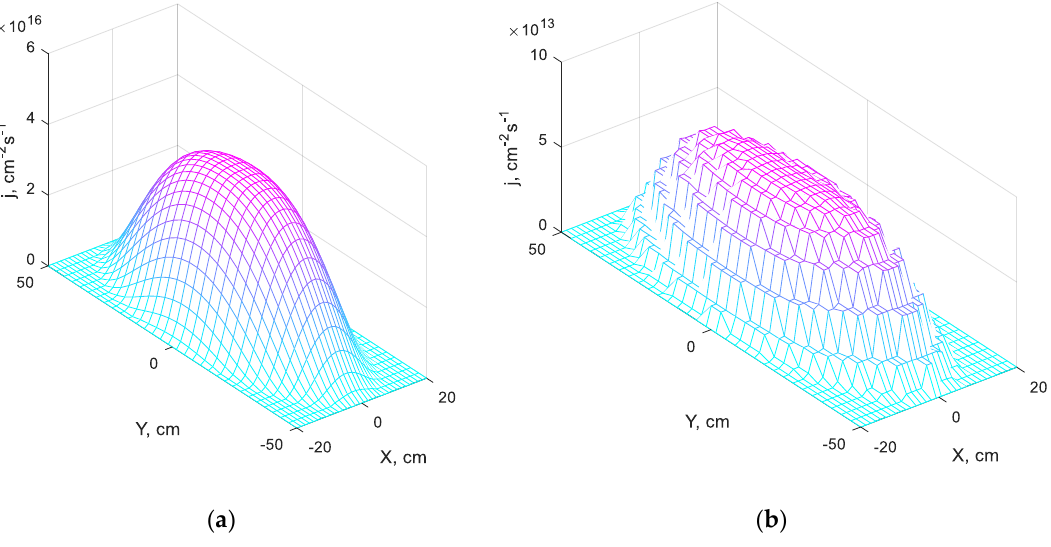
Figure 10. (a) Initial neutral particle current density distribution over the beam cross-section; (b) Residual neutral particle current density distribution over the beam cross-section (shine-through) for the beam with tangency radius R = 2056 mm corresponding to the red colour in Figure 8 (a).